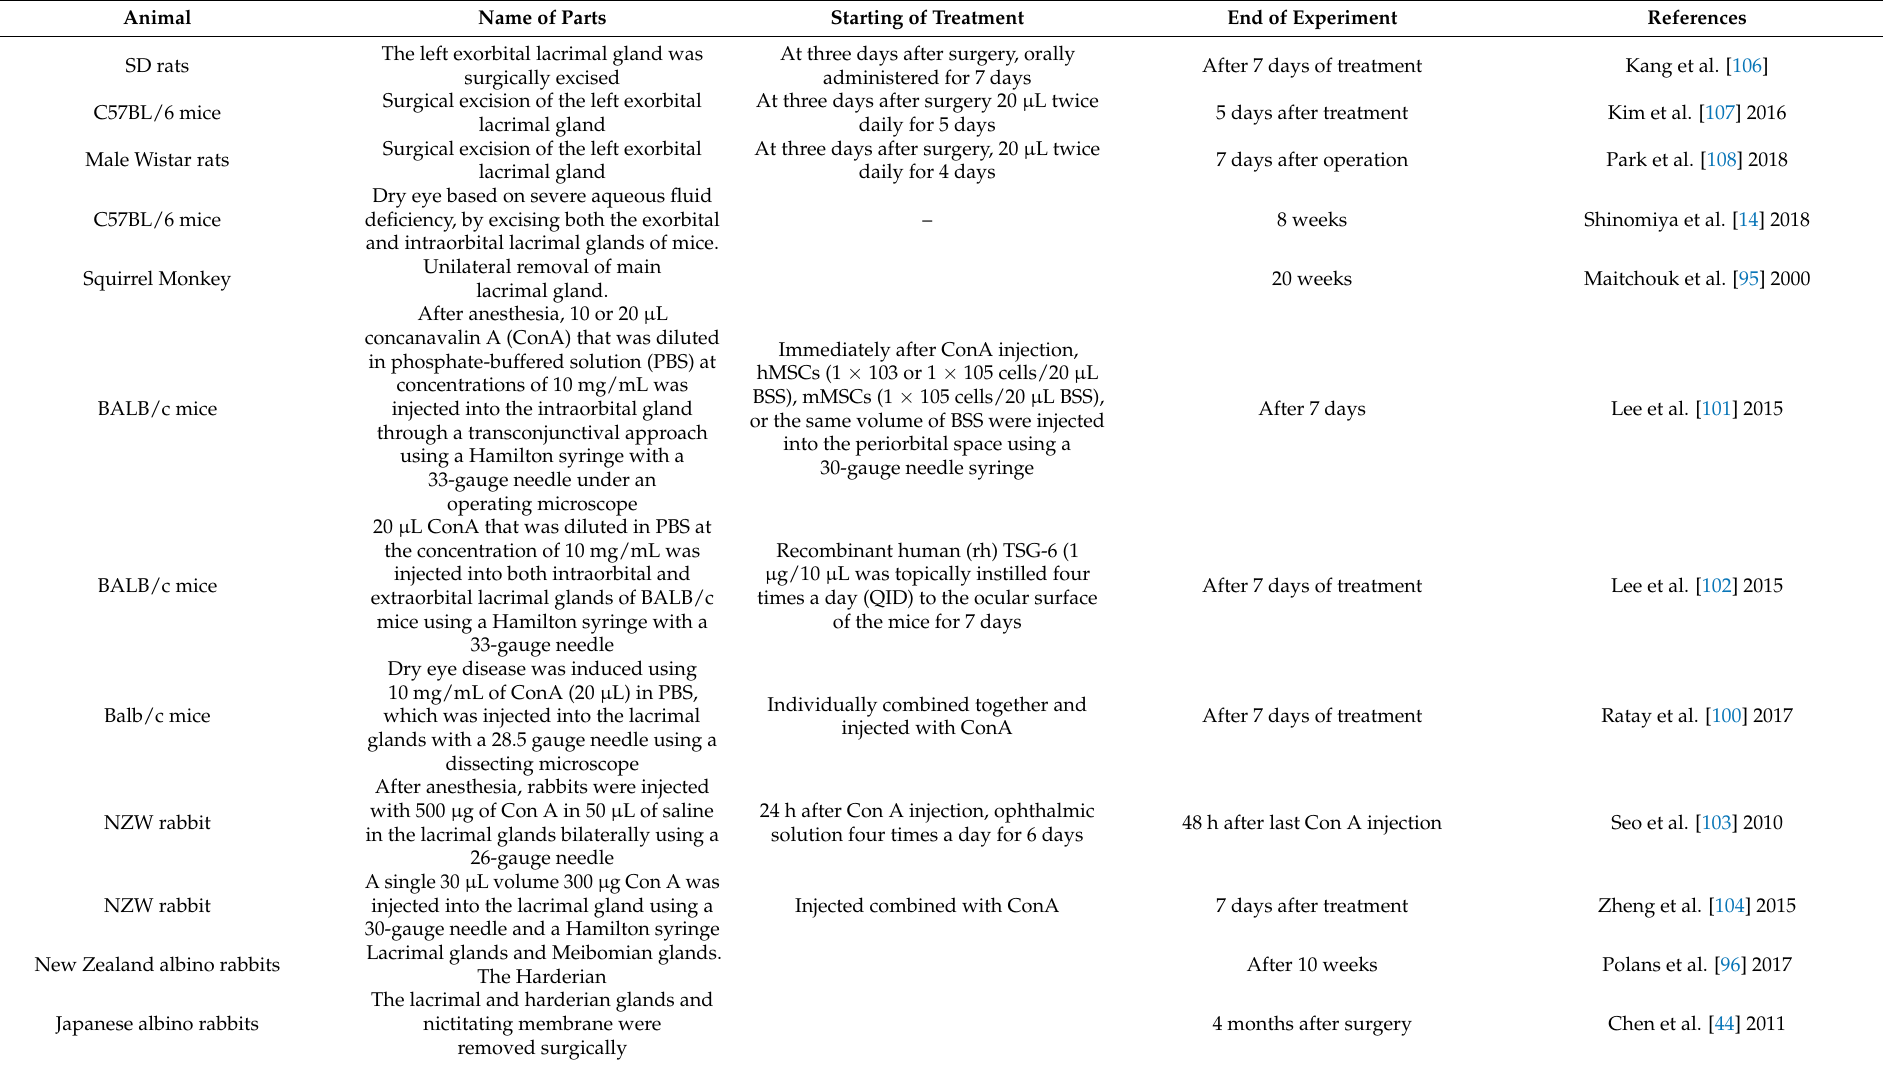
Table 4. Surgical methods of DED induction and experiment